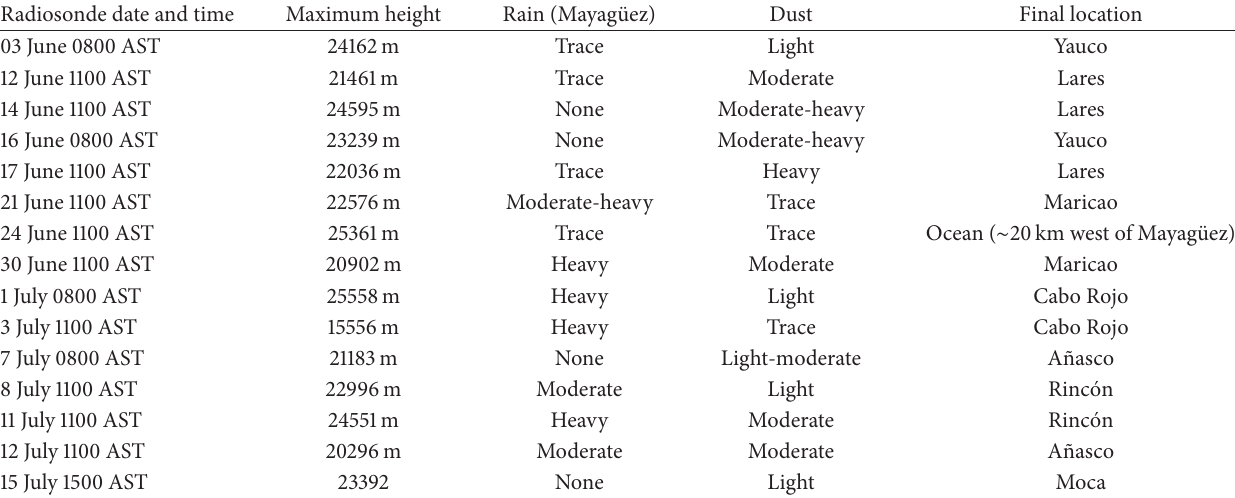
Table 1: Radiosonde launches.